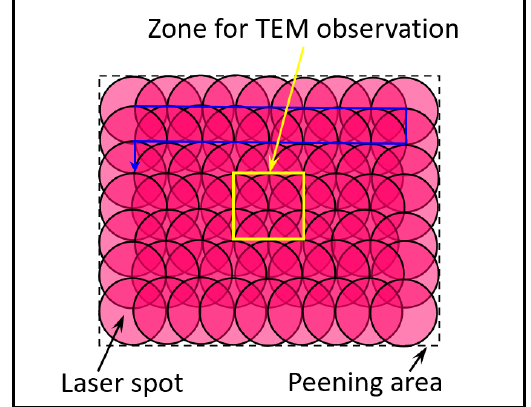
Figure 4. Zone for TEM observation at each depth position.